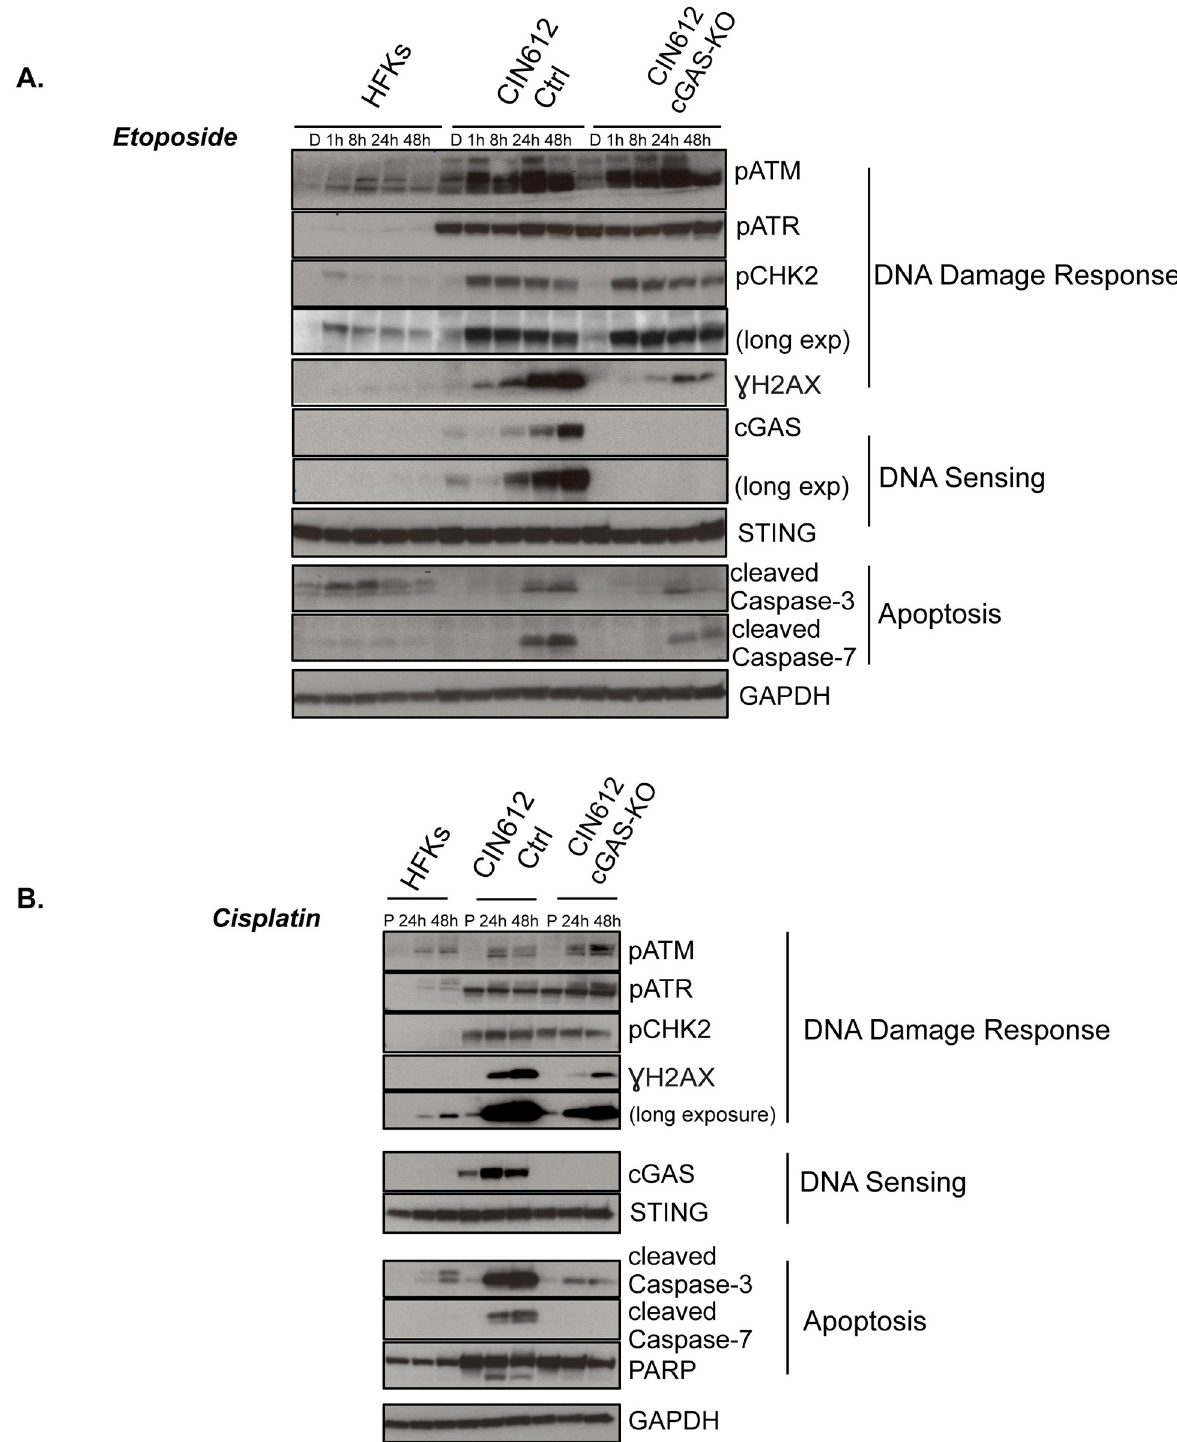
Fig 8. HPV positive cells lacking cGAS display lower levels of γ H2AX and cleaved caspases 3/7. (A) Time course western blot analysis for DNA damage repair factors and cleaved caspase 3/7 in CIN612 pLenti control and CIN612 cGAS-KO cells in response to 50 μ M etoposide treatment or DMSO for the indicated times. (B) Time course western analysis of same cells as in (A) in response to 5 μ M cisplatin treatment or PBS for 24 and 48 hrs. Similar results were seen in three or more independent experiments.